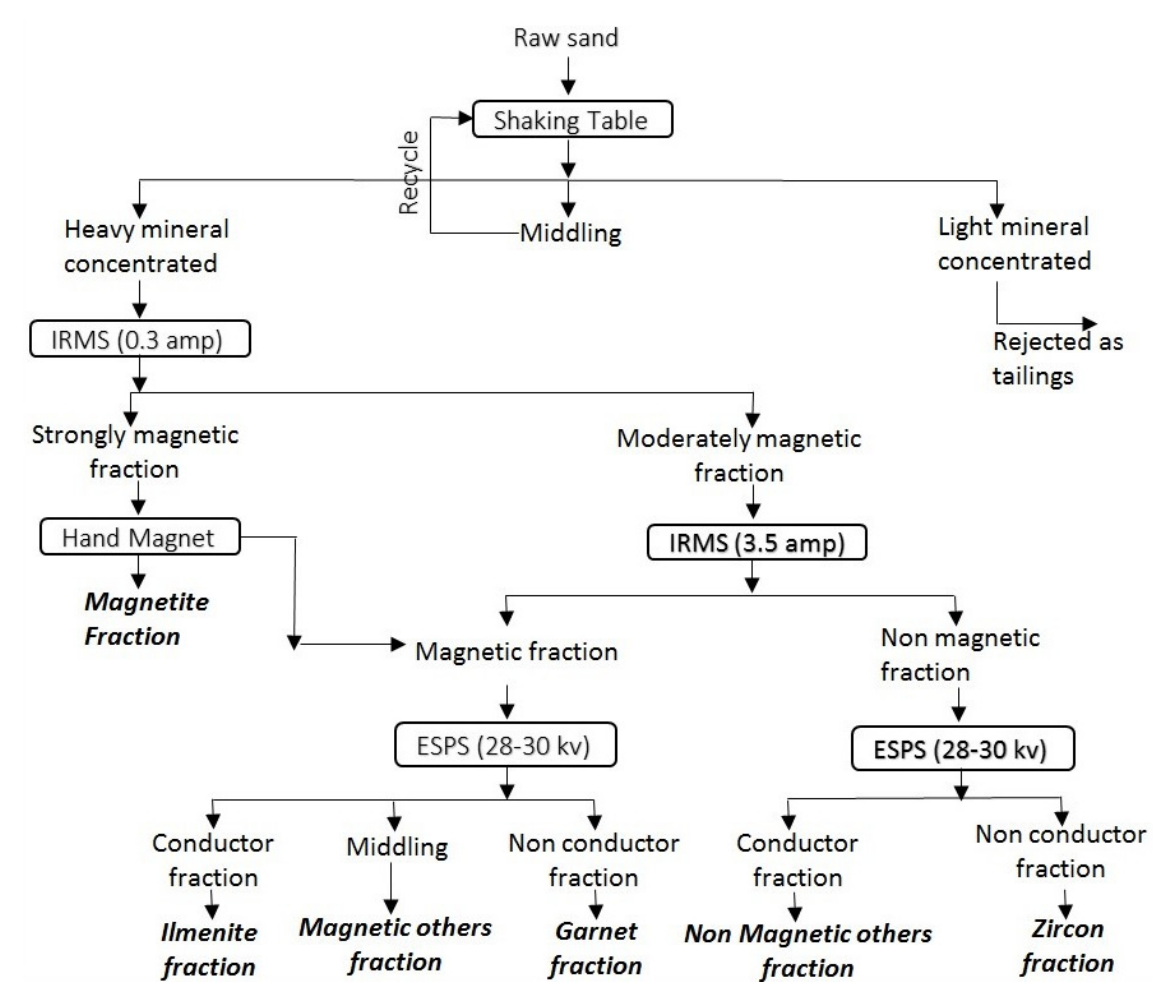
Figure 2. Flow chart showing the procedure for separation of VHM fractions from the bulk sand sample.